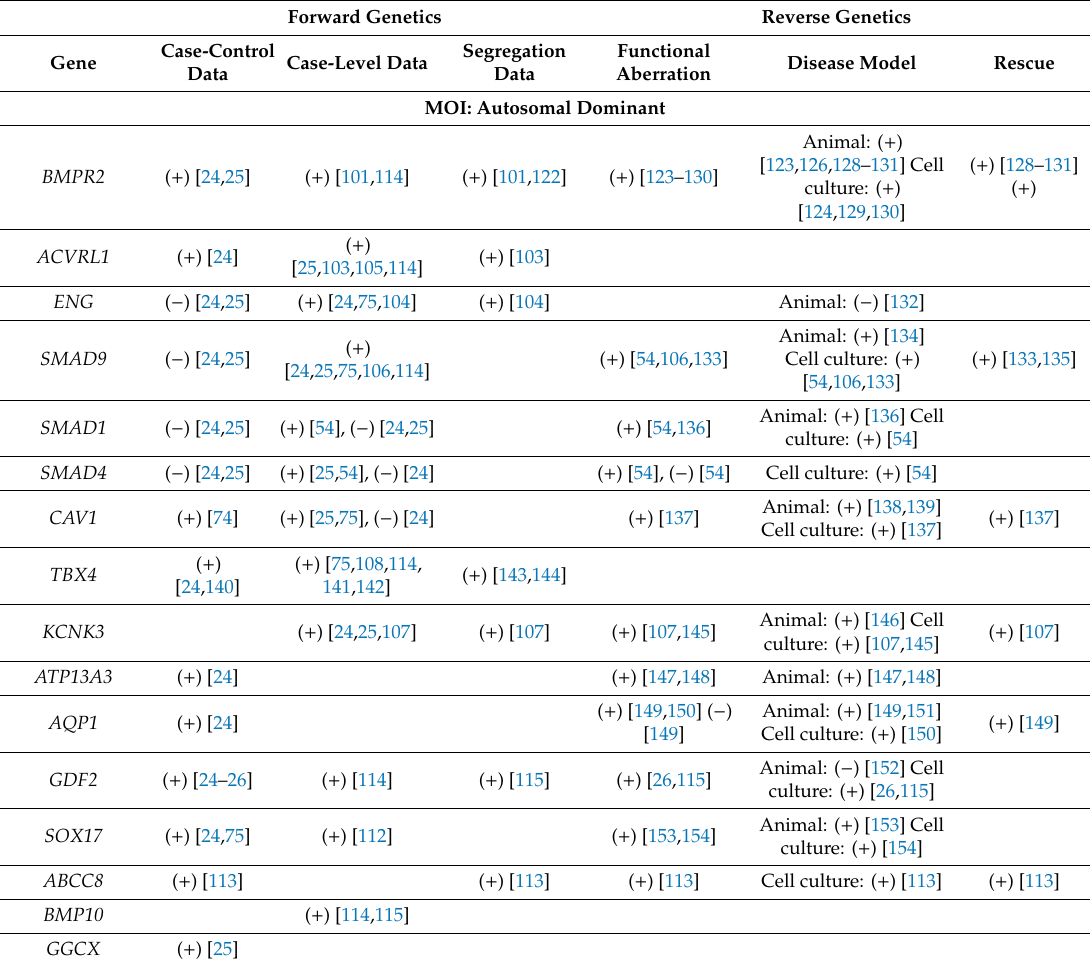
Table 3. Supporting evidence for the role of risk genes in PAH pathogenesis. Abbreviations: ( + ) indicates that the paper provides information in favour of the role of the given gene in the pathogenesis of PAH, ( − ) indicates that the paper does not provide support for the role of the given gene in the pathogenesis of